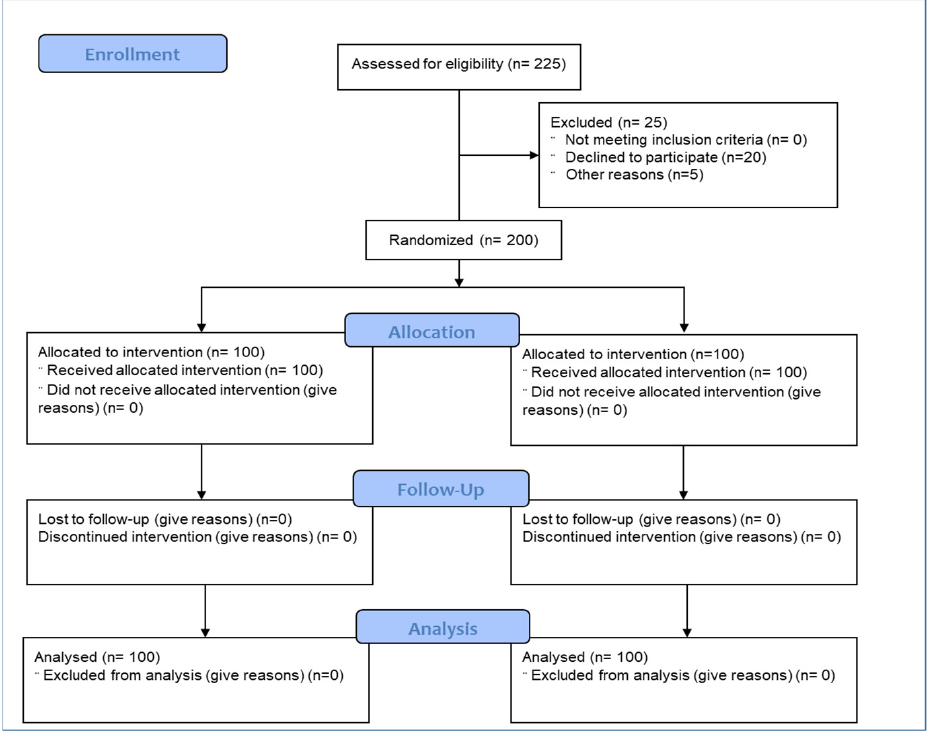
Figure 1. Participant flow chart.